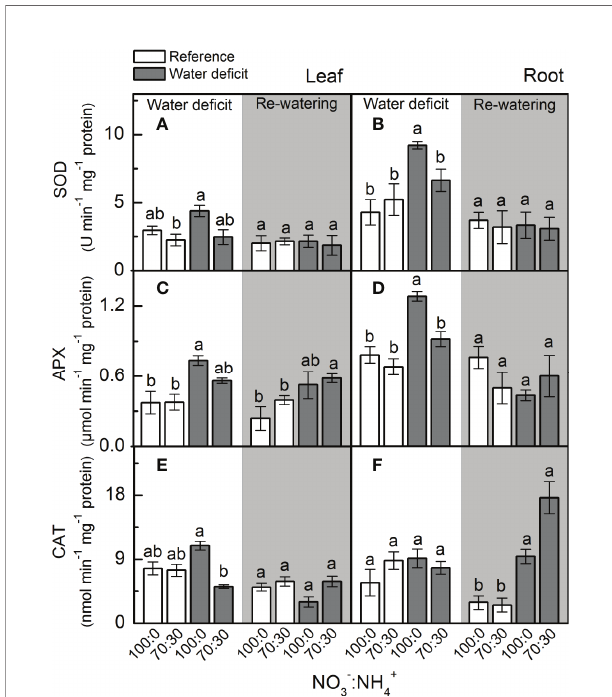
FIGURE 5 | Superoxide dismutase activity [SOD, in (A, B) ], ascorbate peroxidase activity [APX, in (C, D) ] and catalase activity [CAT, in (E, F) ] in leaves (A , C , E) and roots (B , D , F) of sugarcane plants maintained well- hydrated (reference, white bars) or subjected to water de fi cit (gray bars) and supplied with varying NO 3 − :NH 4+ ratios: 100:0 and 70:30. The white area indicates the period of water de fi cit and the shaded area indicates the period of re-water. Bars represent the mean value of four biological replicates ± se. Different letters indicate statistical difference (BF 10 > 3) among treatments in a given evaluation.